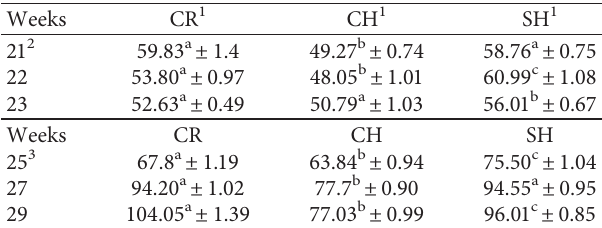
Table 3: Mean levels of hormones, metabolites, and liver enzymes of Nicobari chickens subjected to different